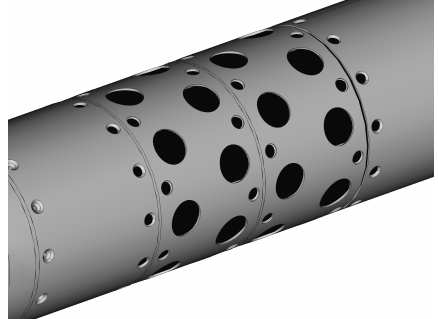
Figure 3. Configuration of the lateral thrusters